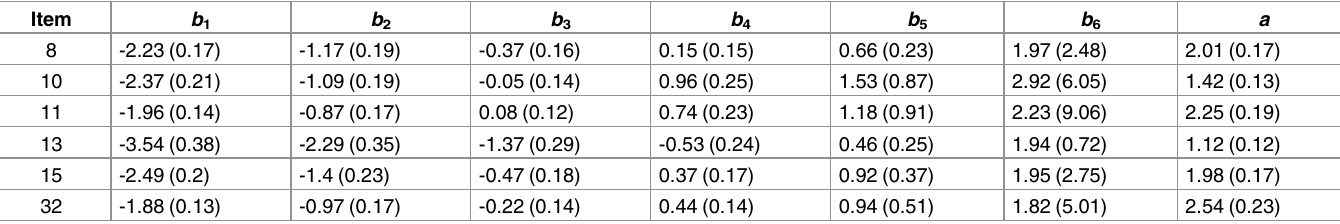
Table 4. Intellectual humility–Intellectual modesty item parameter estimates.